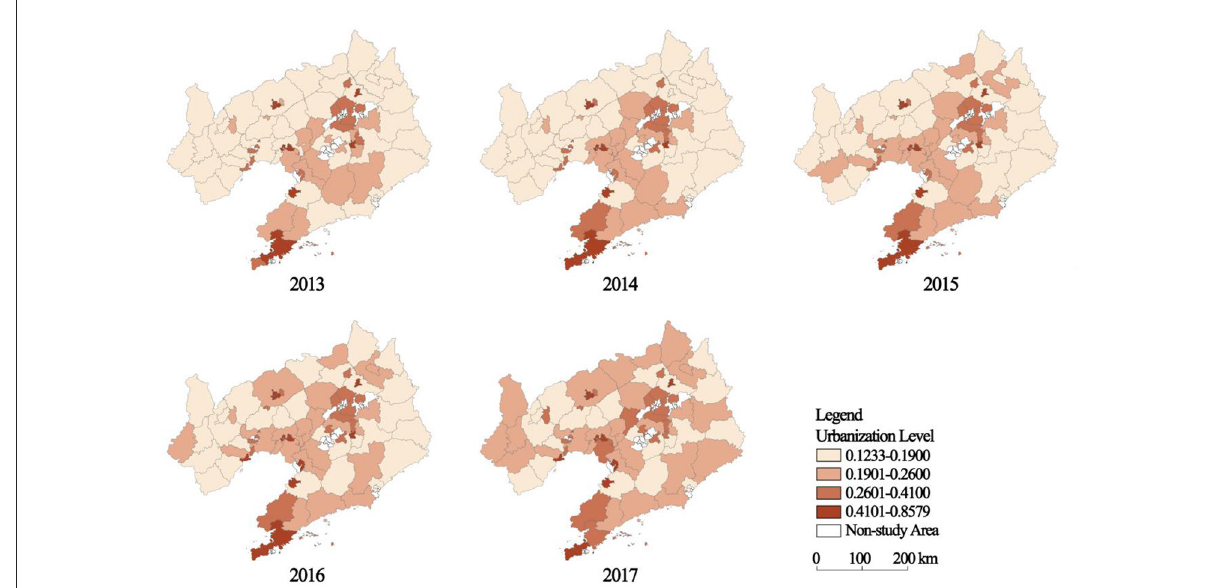
FIGURE2 Spatial pattern of urbanization in agricultural counties and districts of Liaoning province